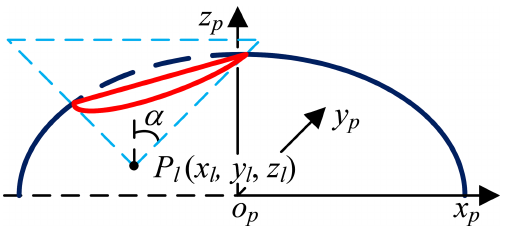
Figure 8. The schematic diagram of candidate